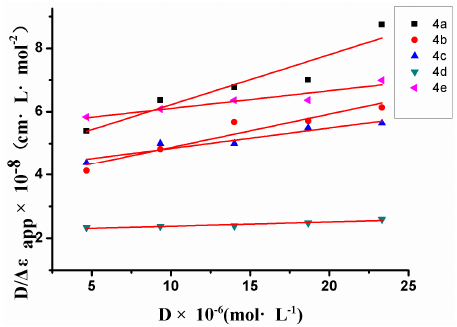
Figure 1. D / Δε app vs. D plot of bis-naphthalimide derivative 4 (50 μ M) with CT DNA in PBS buffer Figure 1. D / ∆ ε app vs. D plot of bis-naphthalimide derivative 4 (50 µ M) with CT DNA in PBS buffer (50.0 mM, pH = 7.4). (50.0 mM, pH = 7.4). Table 1. The K b values of compounds 4a – e with CT DNA. Table 1. The K b values of compounds 4a – e with CT DNA.